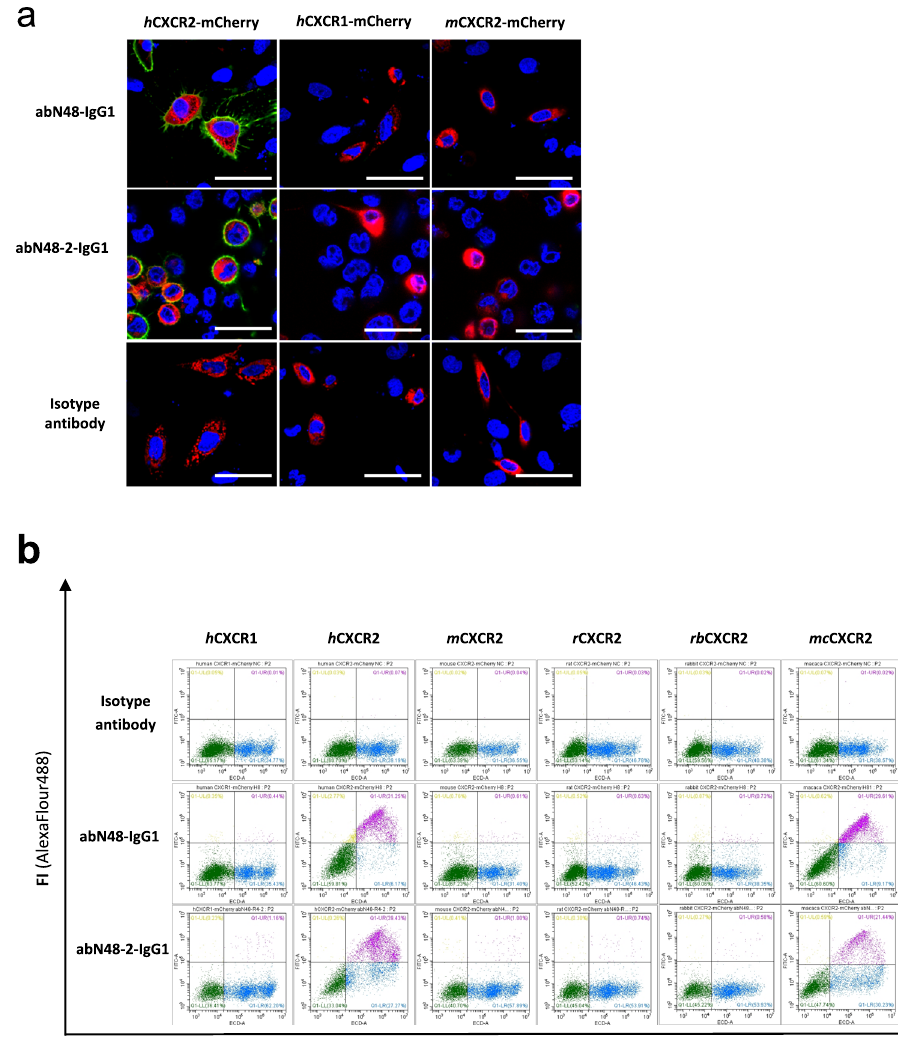
Fig. 2 Species and subtype speci fi city of abN48-IgG1 and ab48-2-IgG1. a Representative images of co-localization of abN48-IgG1 or abN48-2-IgG1 to h CXCR2, h CXCR1, and m CXCR2 overexpressed on the membrane of U2OS cells. All test receptor proteins were fused with an mCherry fl uorescent tag, and the immunocyto fl uorescent images were captured by confocal microscopy (3 images of every 3 samples were analyzed for each group and all gave consistent results). Scale bars (white) represent 50 μ m. b Surface interactions of abN48-IgG1 and abN48-2-IgG1 with h CXCR2, h CXCR1, m CXCR2, r CXCR2, rb CXCR2, and mc CXCR2 overexpressed on U2OS cells. Flow-cytometry was used to measure the interactions between antibodies and the CXCR2 receptor proteins. Isotype-antibody (irrelevant human IgG1 antibody) was used as a negative control. For each sample, 3 repeats were carried out and all gave consistent